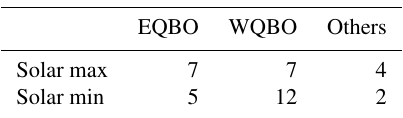
Figure A3. (a) October–November–December (OND) mean OLR differences between EQBO and WQBO winters for solar mini- mum winters. (b) Same as panel (a) but for solar maximum years. (c) OND OLR differences between solar minimum and maximum winters with 1-year lag. The green line denotes the statistically sig- nificant value at the 95% confidence